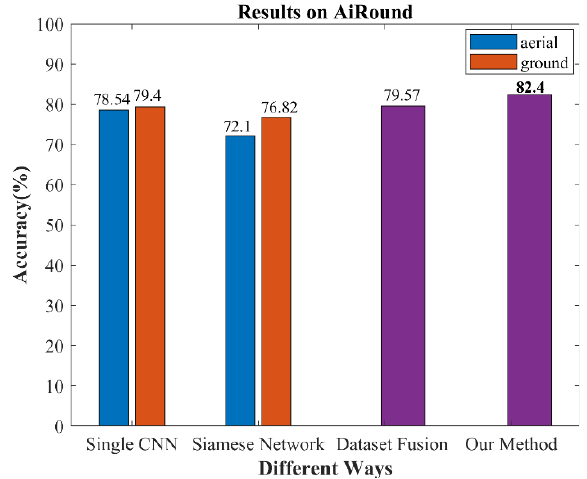
Figure 7. Results of different methods on Airound